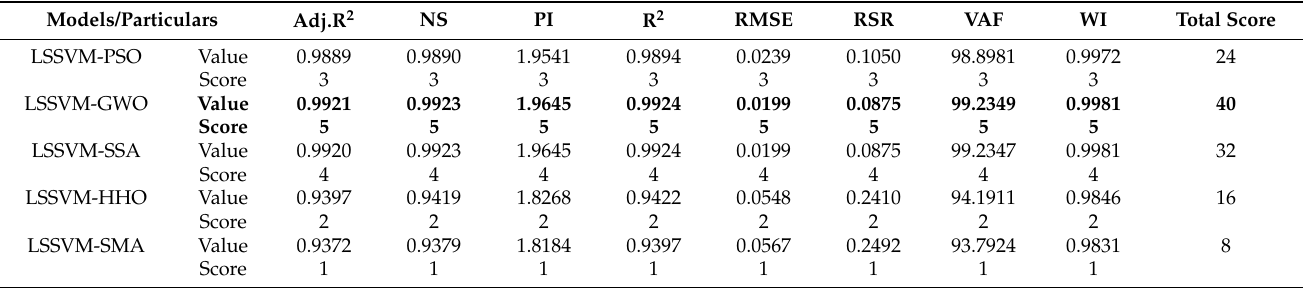
Table 5. Performance parameters for the training dataset.